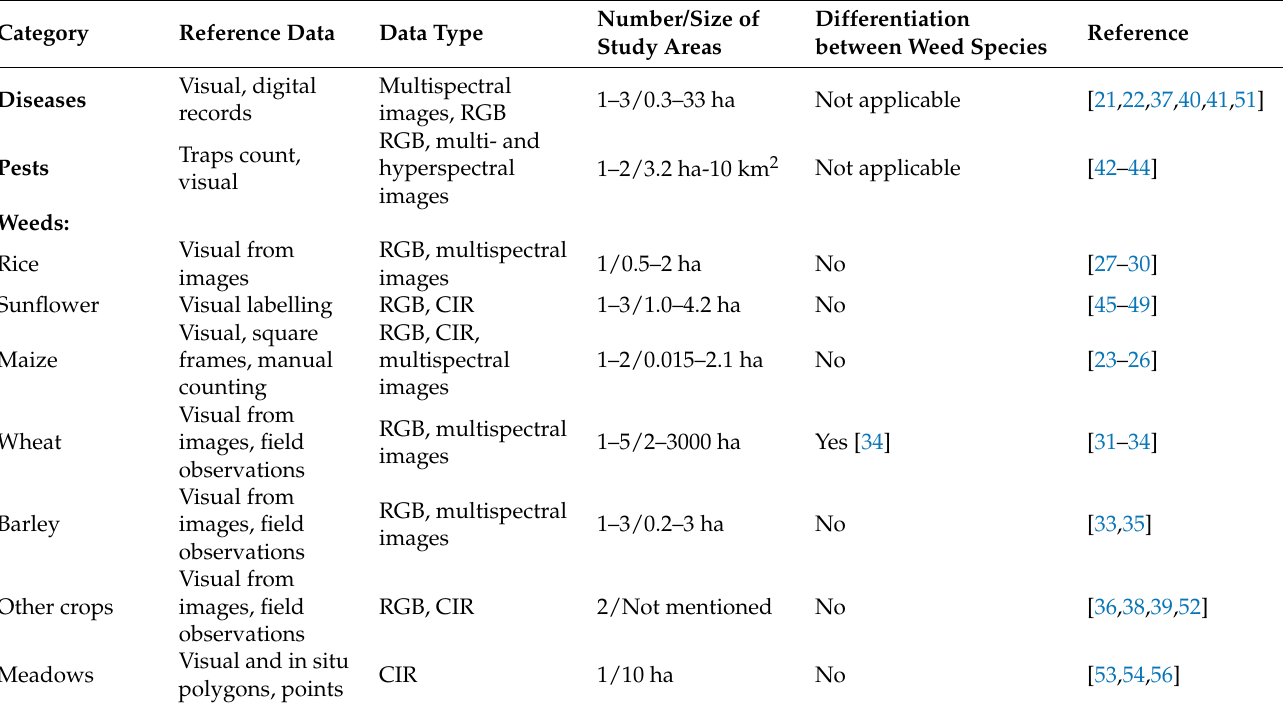
Table 1. Reviewed studies in nine categories with information on main reference methods, collected UAV data types, and possible differentiation between weed